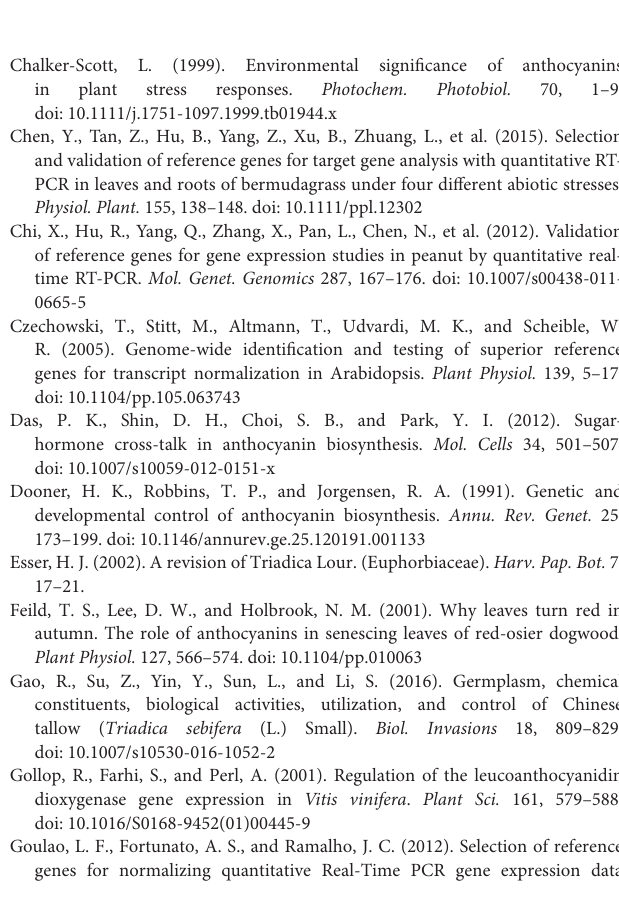
Figure S1 | Agarose gel (1.2 %) electrophoresis of the RNA. Figure S2 | Melting curves of 12 reference genes showing single peaks. Figure S3 | Agarose gel (2%) electrophoresis showing amplification of a single PCR product of the expected size; M represents DL2000 DNA marker. Table S1 | RNA purity. Table S2 | Cycle threshold (Ct) values for twelve candidate reference